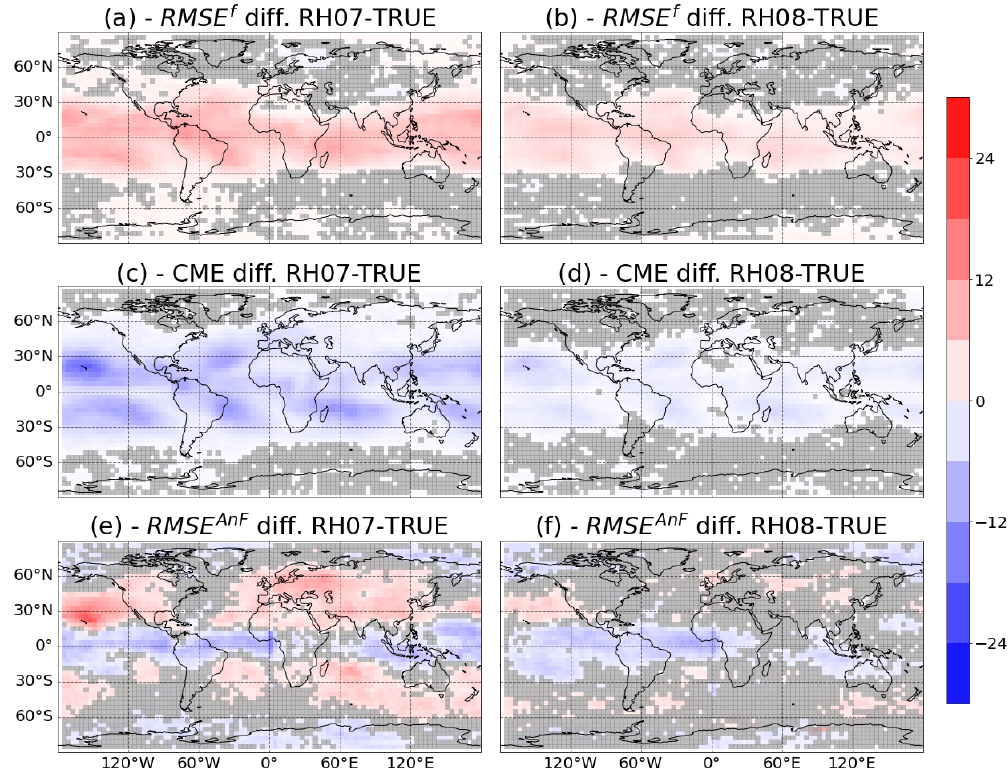
Figure 7. Percentage difference in RMSE f (a, b) and CME (c, d) for the AnDA experiments performed using the RH07 and RH08 catalogs ( a , c , e and b , d , f , respectively) versus the experiment performed with the TRUE catalog. The images (e) and (f) correspond to the difference in RMSE AnF from the experiment based only on analog forecasting (AnF). In all panels, the gray shade indicates values which are below the 95% statistical significance